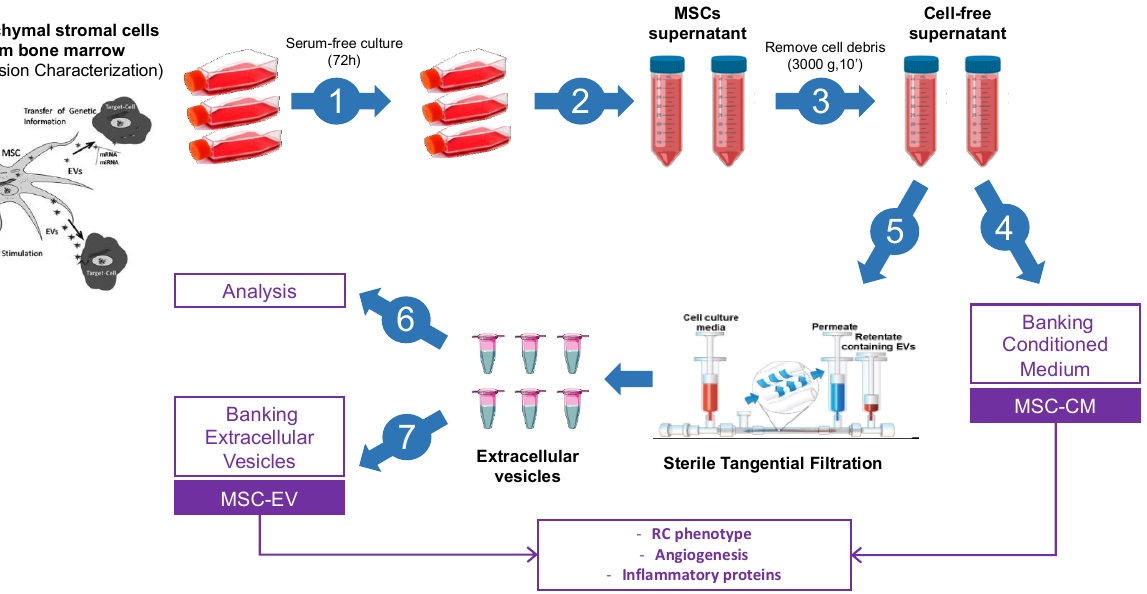
Figure 1. MSC-CM and MSC-EV collection . MSC-CM and MSC-EVs collection and characterization are performed in 7 distinct steps: ( 1 ) expansion, ( 2 – 3 ) obtain cell-free supernatants, after cell culture in serum-free medium (72 h). Cell-free supernatants divided into two parts. One part corresponding to MSC-CM ( 4 ). The second part filtered by tangential filtration for isolated MSCEV ( 5 ) and analyzed ( 6 ). ( 7 ) Banking of MSC-EV.